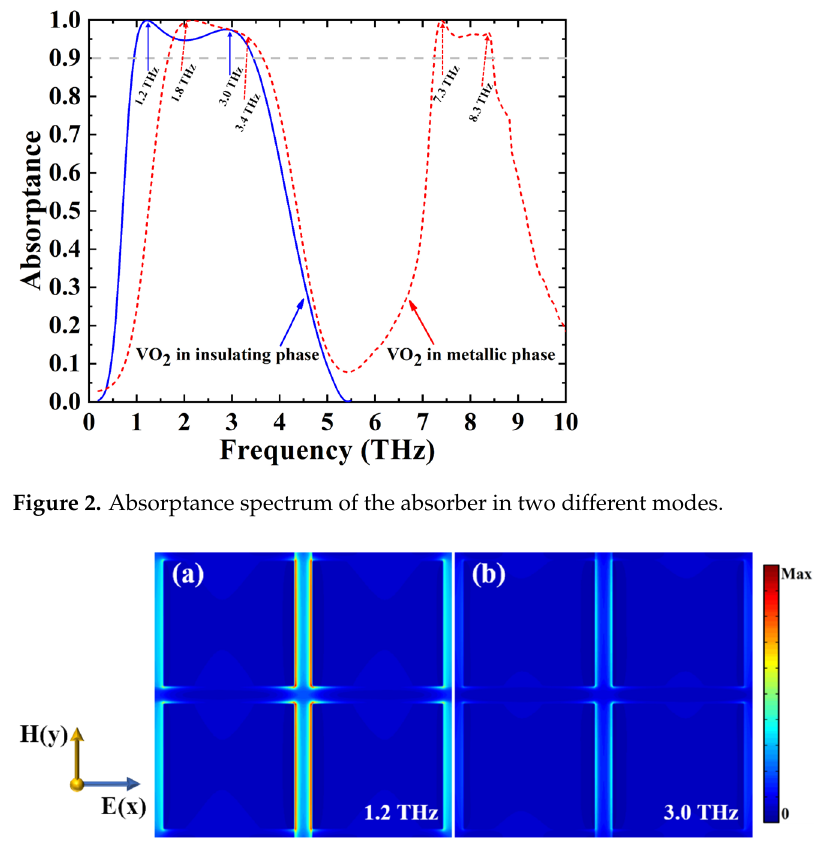
Figure 3. Electric field distribution of graphene patch layer in xoy plane at ( a ) 1.2 THz, and ( b ) 3 THz.